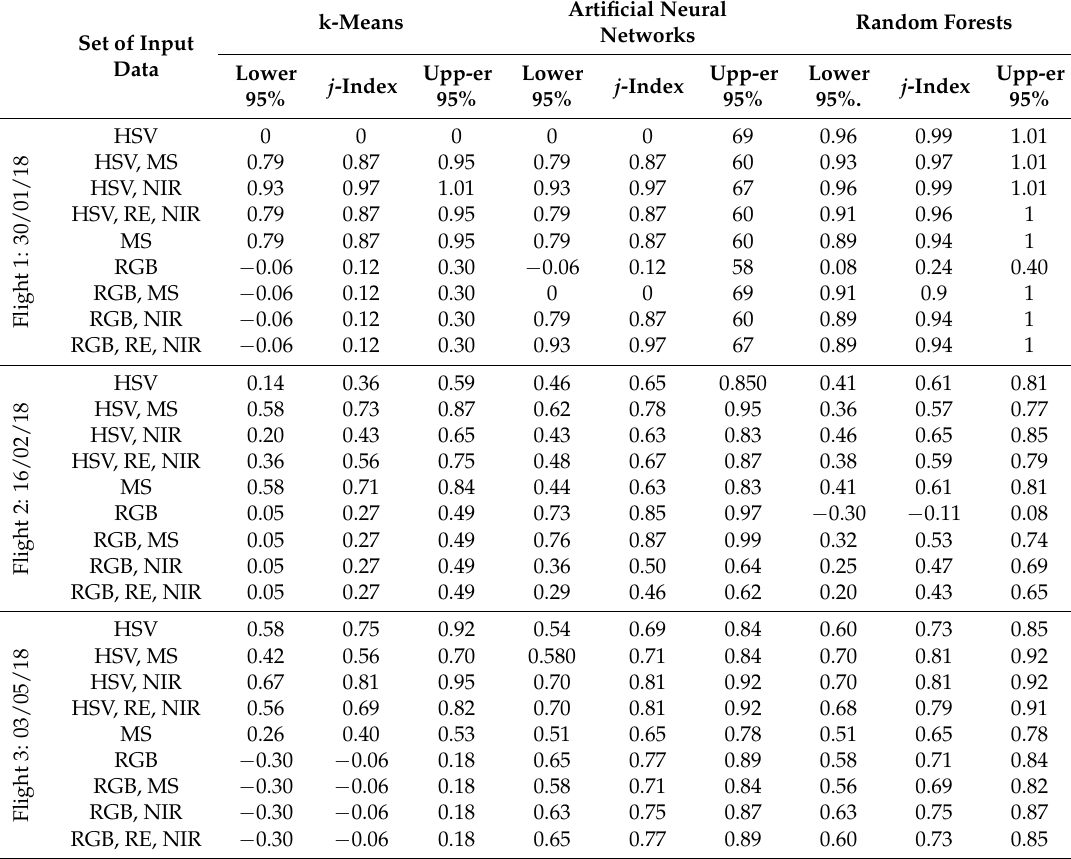
Table 4. j -index and the upper and lower 95% confidence intervals for all flights and classifications. The statistical similarity is shown by values of the j -index falling within the confidence intervals of other classifications.